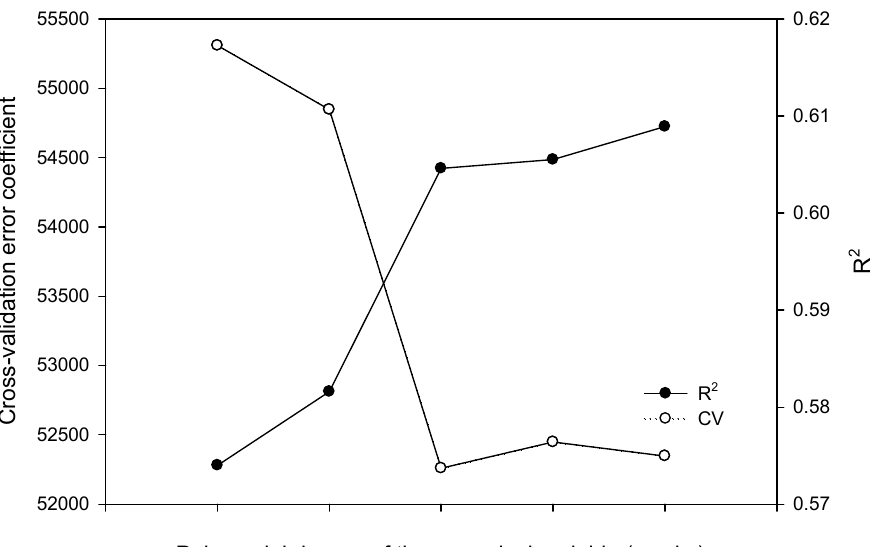
Figure 2. For the data set of the Ca 2+ concentration in the soil solution, the R 2 and the cross-validation error coefficient (CV) for the different polynomial grades of the numerical variable (weeks). In all polynomial grades, the two categorical variables are considered.